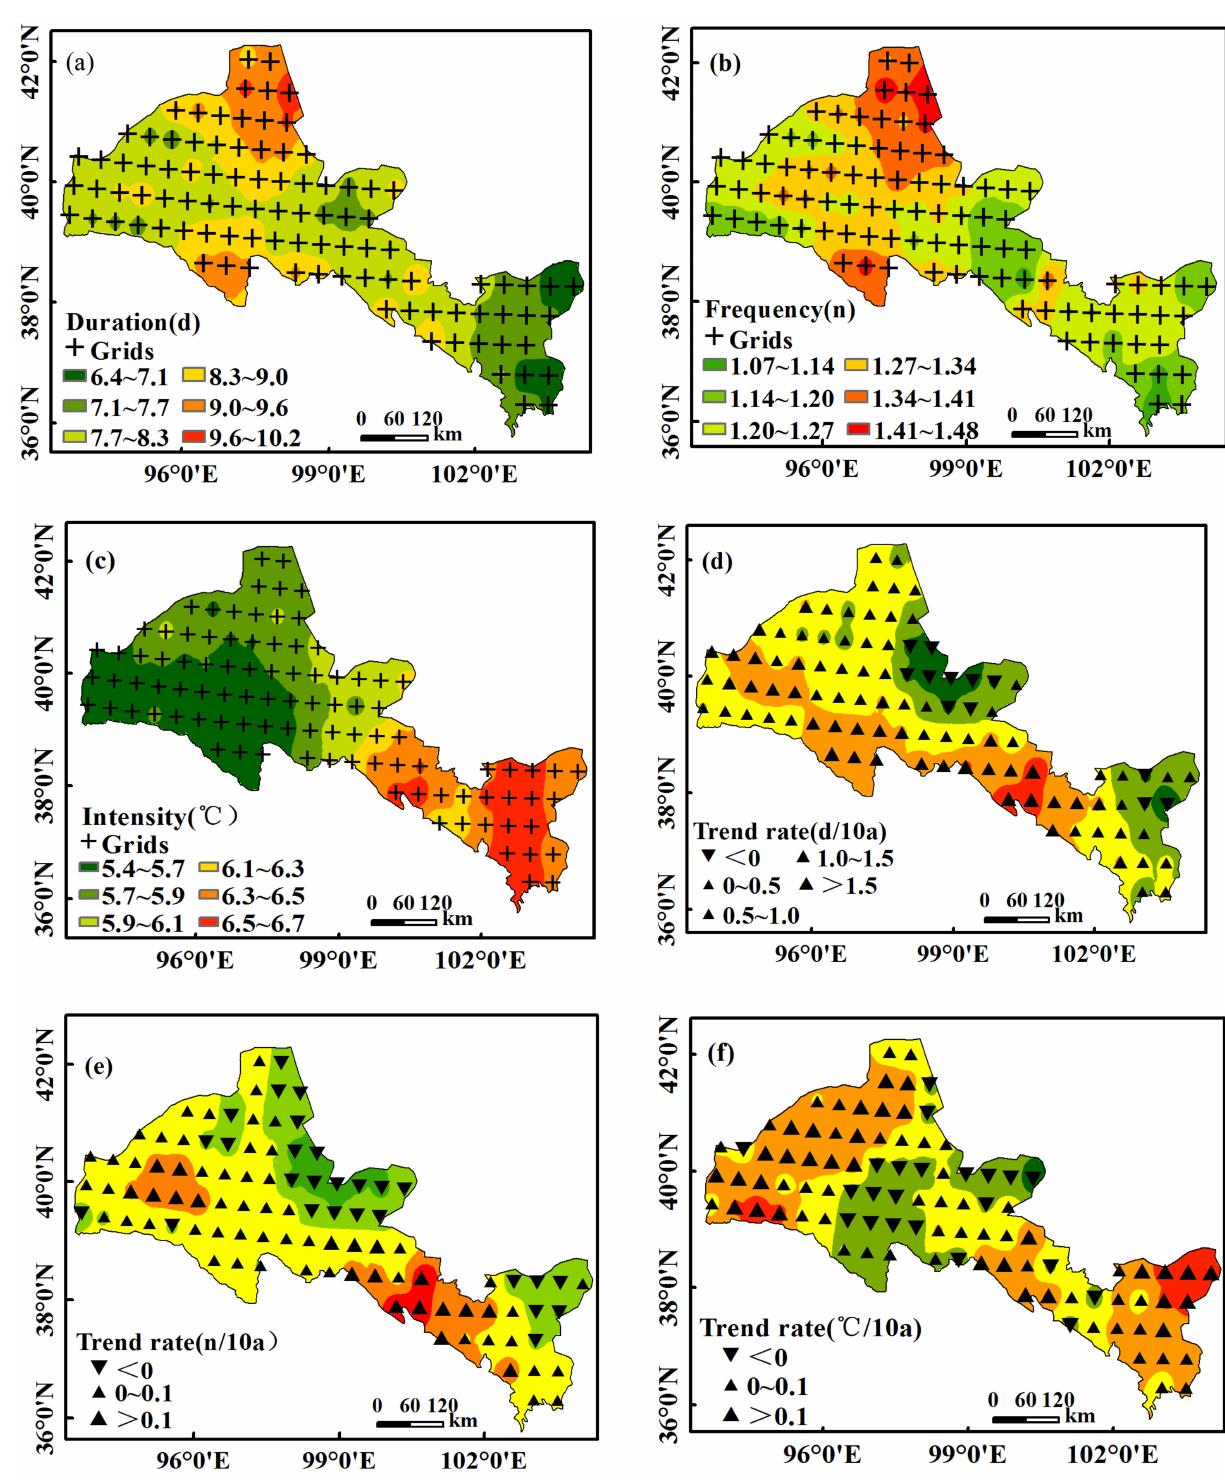
Figure 3. Spatial variation of duration ( a ), frequency ( b ) and intensity ( c ) as well as the tendency rates of duration ( d ), frequency ( e ) and intensity ( f ) of high-temperature heatwaves in Hexi